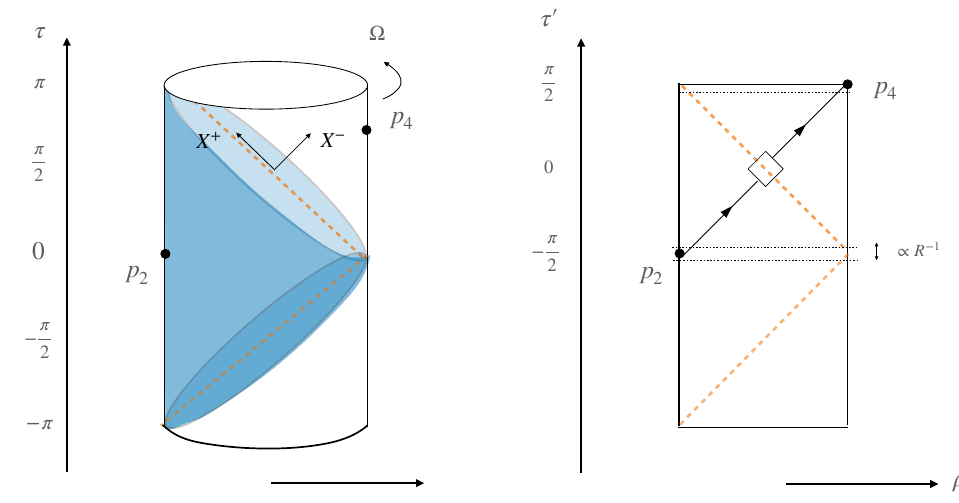
Figure 3 . Left: Poincaré patch of AdS 4 with a shockwave along the horizon at X − = 0 . The boundary is approached as ρ → π Zooming into a bulk flat space region of AdS around the shock at ρ = 0 . As R → ∞ , the AdS shockwave two-point function with p the celestial shockwave two-point